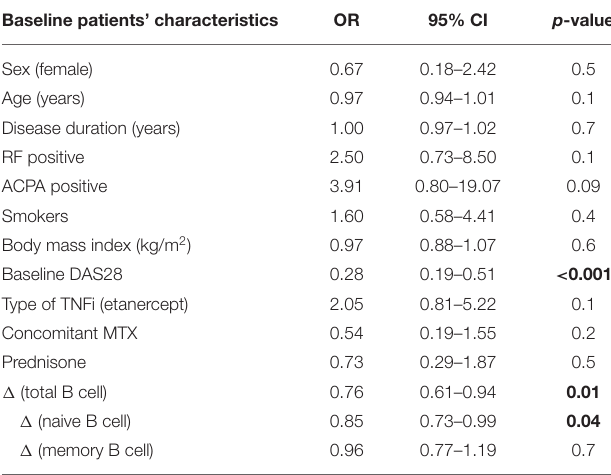
TABLE 2 | Association between patients’ characteristics and clinical remission (DAS28 ≤ 2.6) after 6 months of TNFi treatment. Baseline patients’